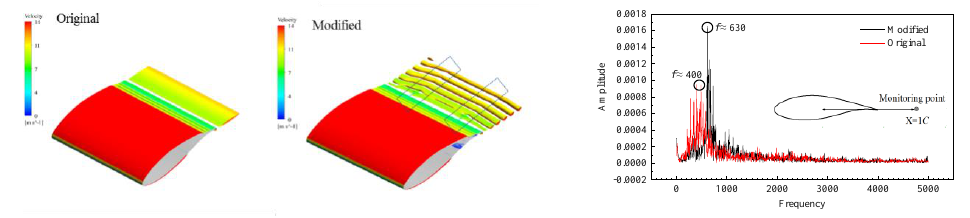
Figure 13. The directivity distribution of airfoil noise with and without the NLPS.